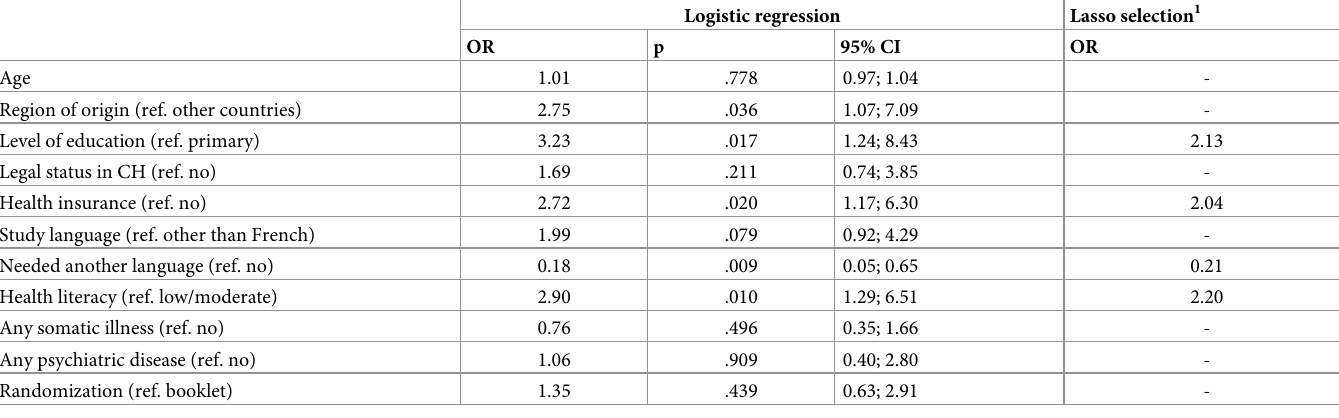
Table 2. Associations between acceptance to sign the consent and